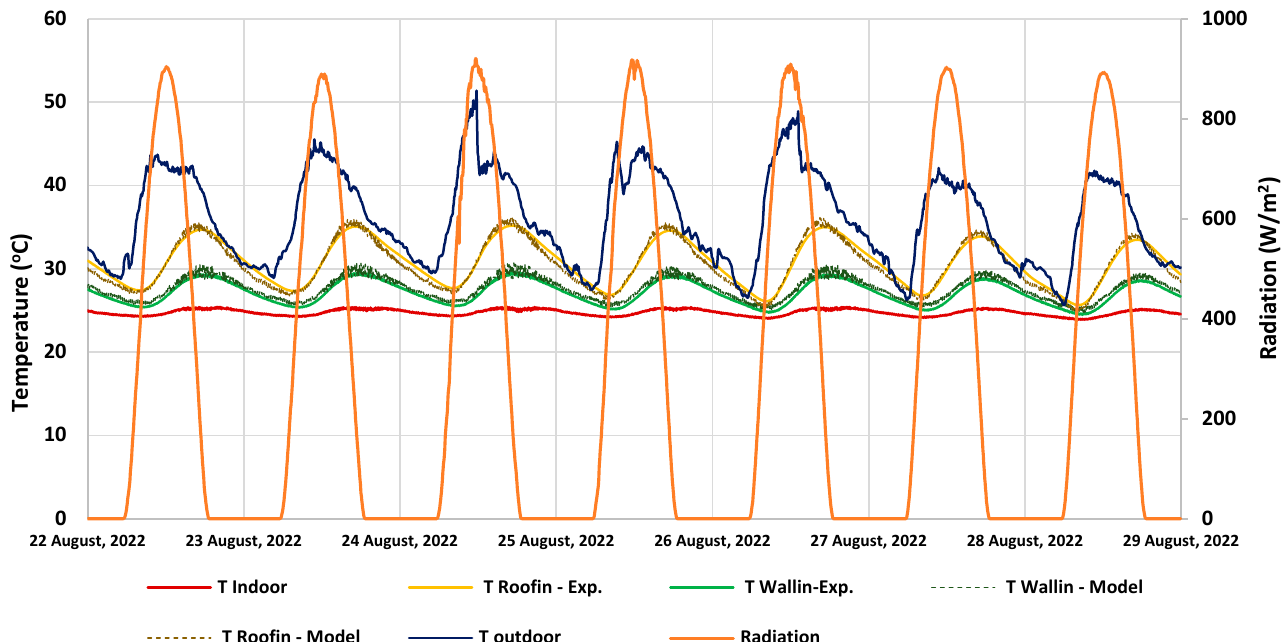
Figure 12. Experimentally measured and model estimated indoor roof and wall temperature profiles. Table 5. Experimental validation of model statistical indices.